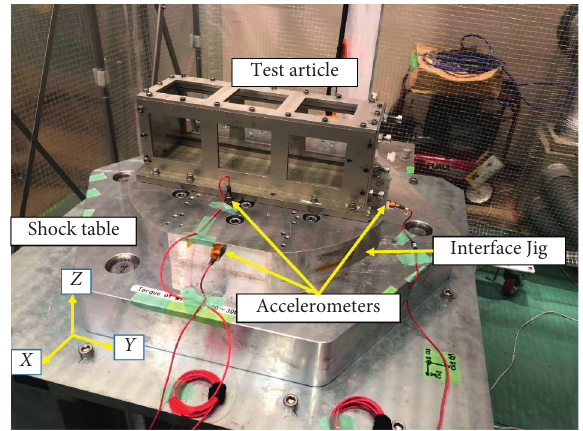
Figure 1: Experimental setup showing the test article and